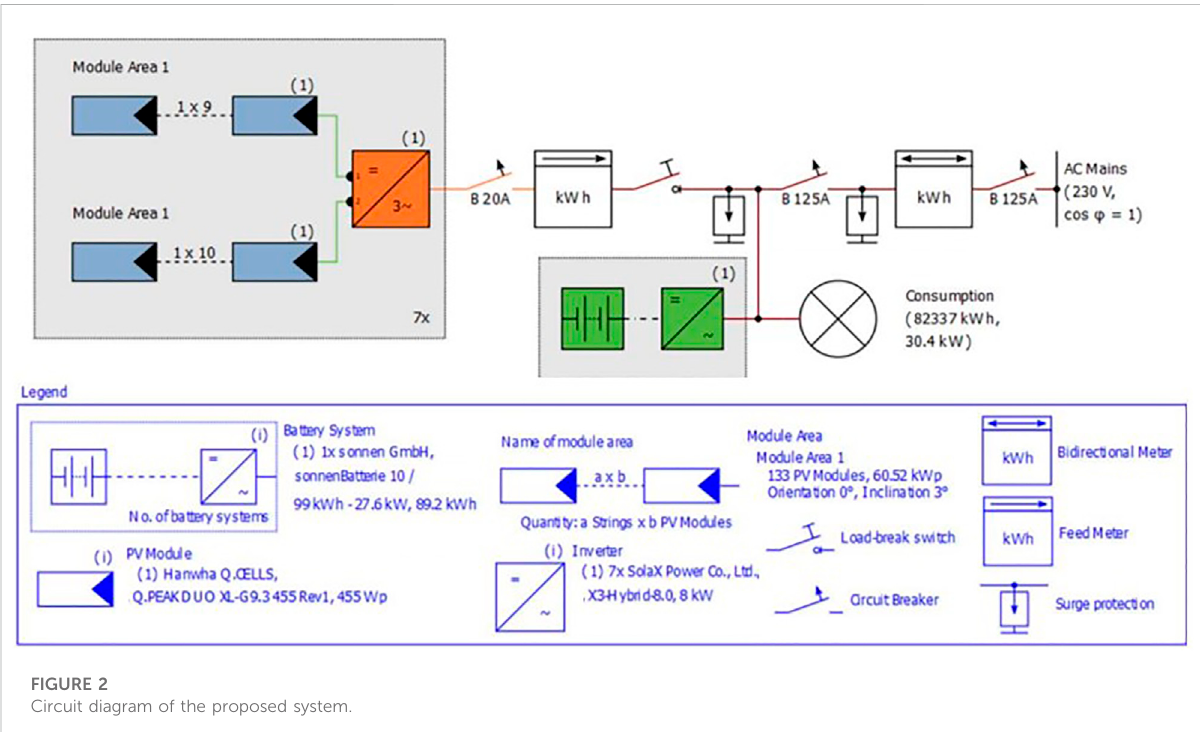
FIGURE 2 Circuit diagram of the proposed system.